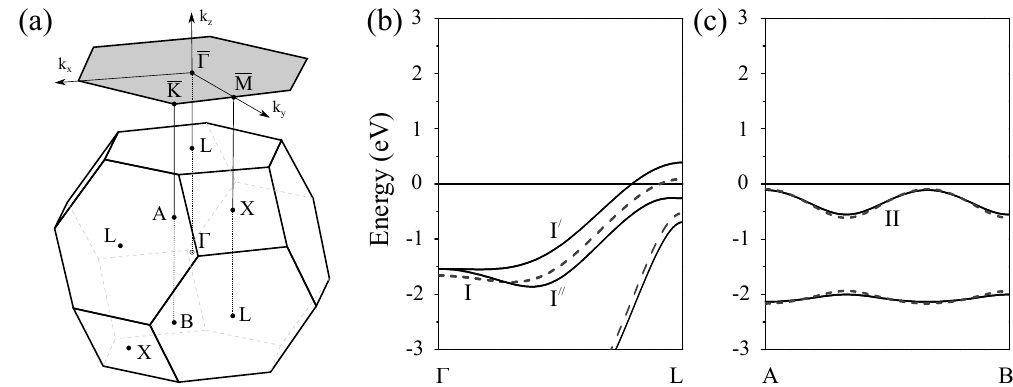
Figure 3. ( a ) bulk Brillouin zone and its projection onto the (111) surface. Bulk electronic structure of Pt along the ( b ) Γ L and ( c ) AB directions of the bulk Brillouin zone [38], determining the Au(111) projected bulk states continuum atthe Γ and K points of the SBZ, respectively. The solid (dashed) lines present energy bands calculated with (without) inclusion of the spin–orbit coupling. One can see how upon inclusion the spin–orbit coupling a four-fold degenerate band I splits in two spin-degenerate states I (cid:48) and I (cid:48)(cid:48) along Γ L. Instead, the other bands, including the band II of interest here, are barely affected by the spin–orbit